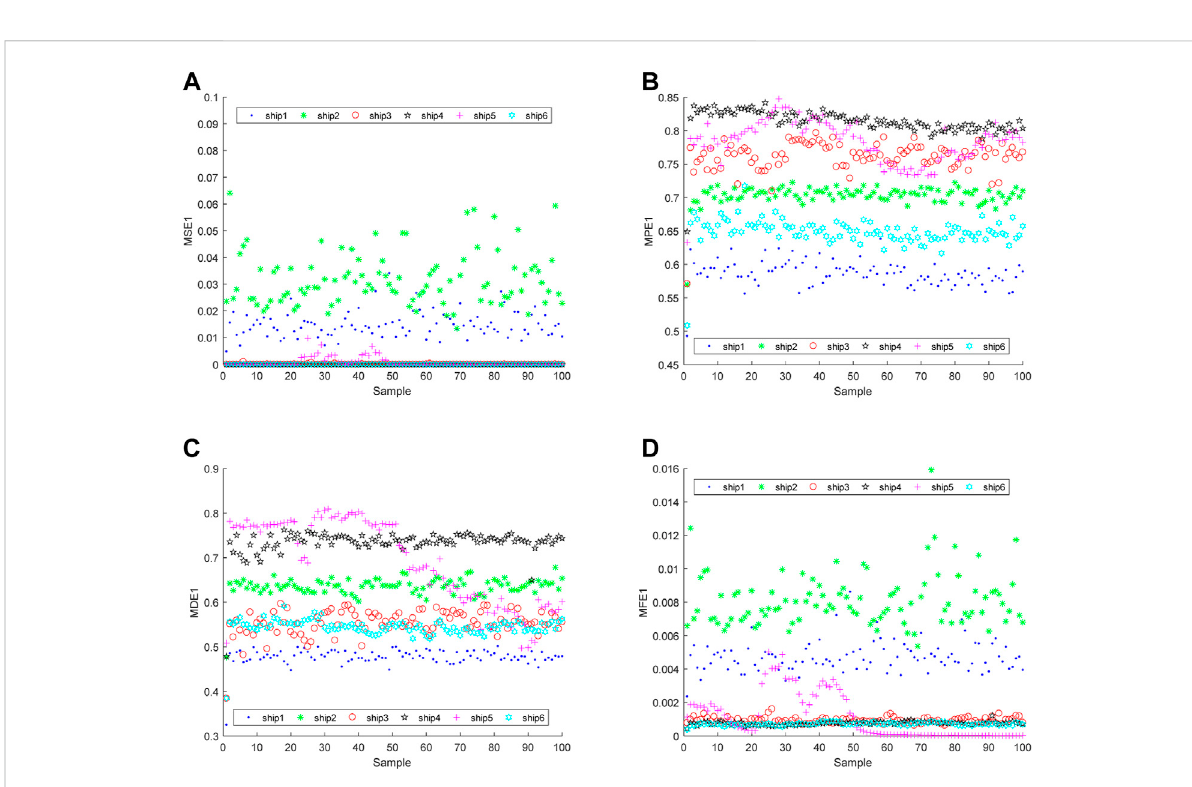
FIGURE 8 Single-feature distributions correspond to the highest ARR for six SRNs. (A) is MSE, (B) is MPE, (C) is MDE, (D) is